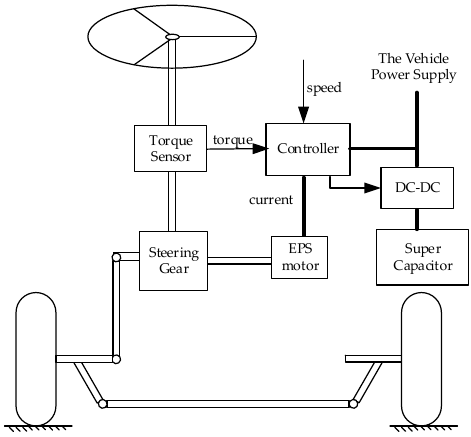
Figure 1. The schematic of the EPS with hybrid power supply (HP-EPS) system.